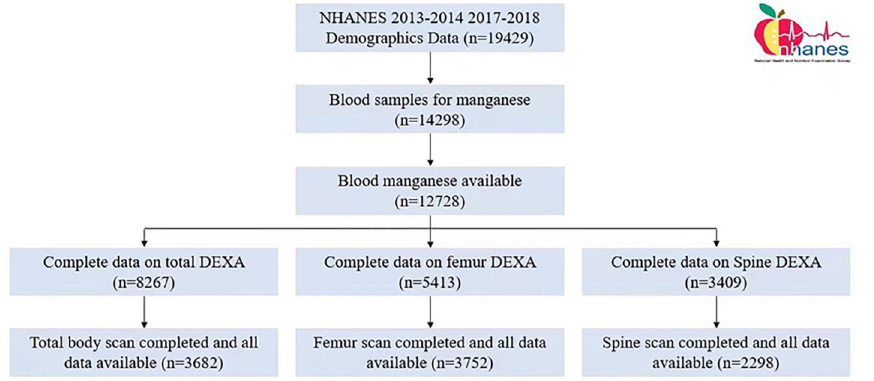
Fig 1. Flow chart. NHANES, National Health and Nutrition Examination Survey; DEXA, Dual Energy X-ray Absorptiometry.